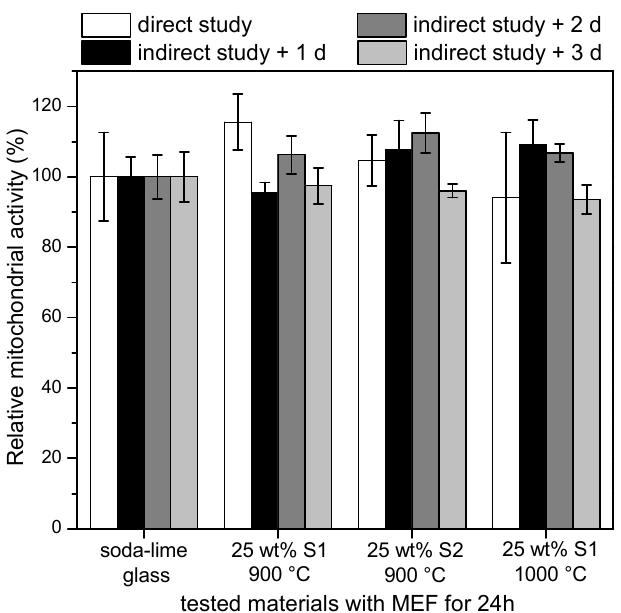
Figure 6. Relative cell viability of slag/glass samples, compared with soda-lime. MEF, mouse embryonic